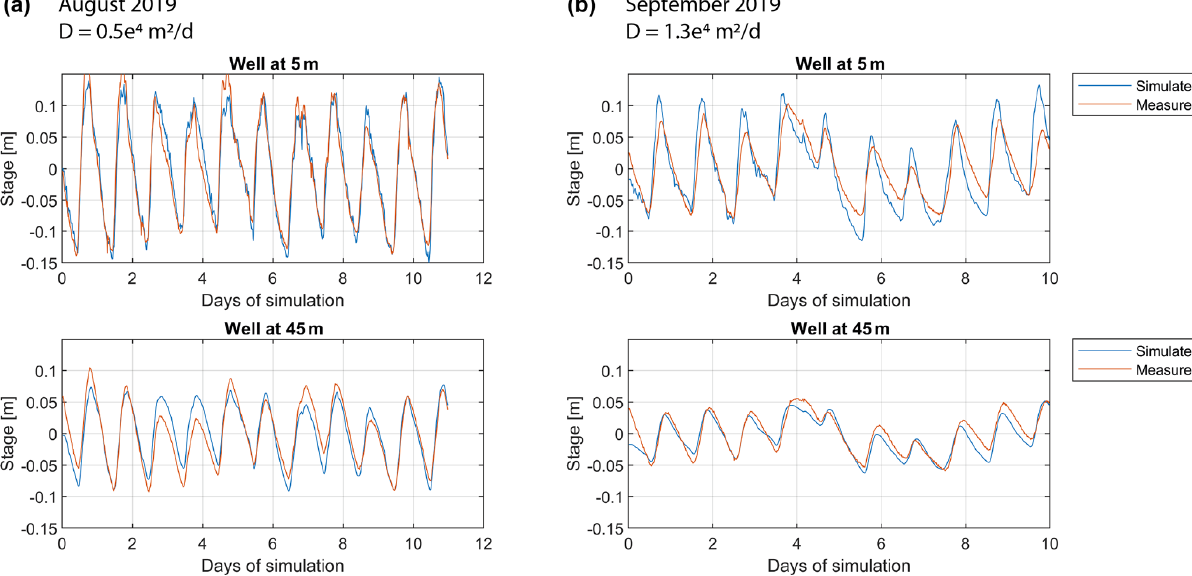
https://doi.org/10.5194/hess-26-6029-2022 Hydrol. Earth Syst. Sci., 26, 6029–6054,